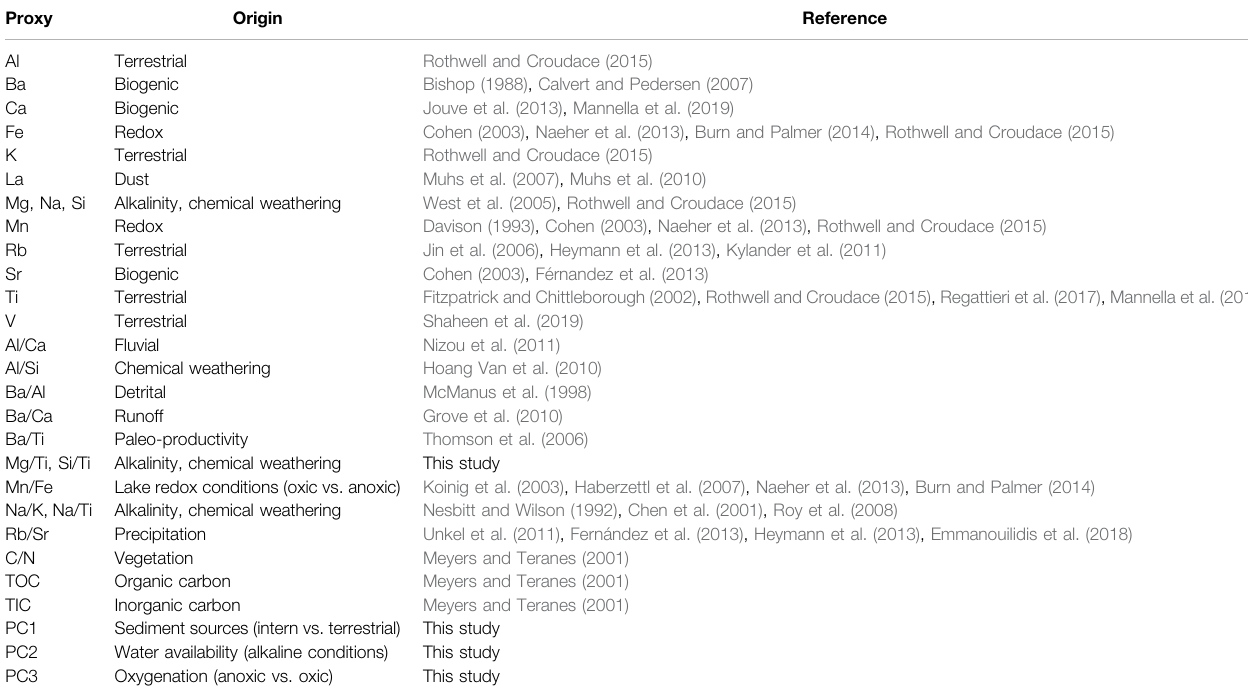
TABLE 6 | Summary of geochemical proxies and their origin applied for the interpretation of MAR-1